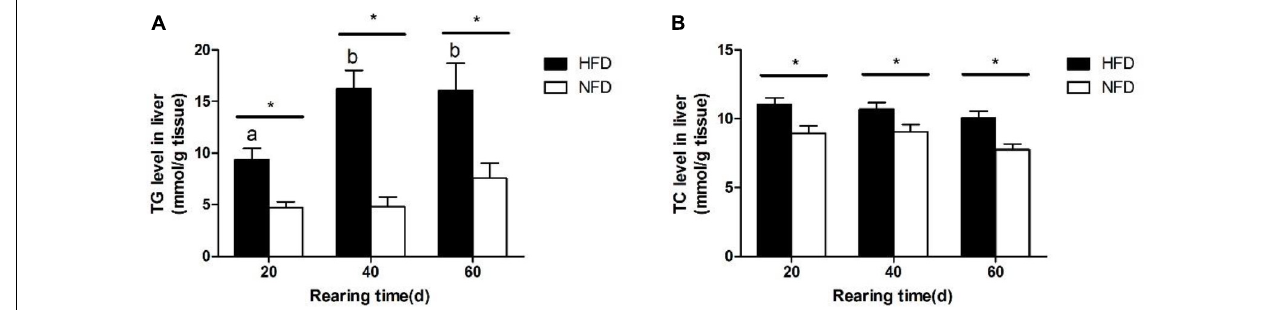
FIGURE 2 | Levels of (A) triglyceride, TG and (B) total cholesterol, TC in liver of GIFT fed experimental diets on day 20, 40, and 60 ( n = 9 replicates per group). Significant differences ( P < 0.05) between high-fat diet (HFD) and normal-fat diet (NFD) groups at same sampling time are marked by asterisks ( ∗ ). Different superscript lowercase letters show significant differences ( P < 0.05) in same group among different sampling times.